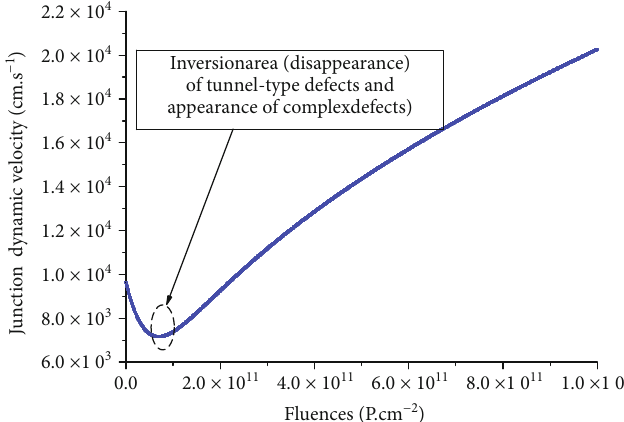
Figure 1: Junction dynamic velocity versus fl uence.